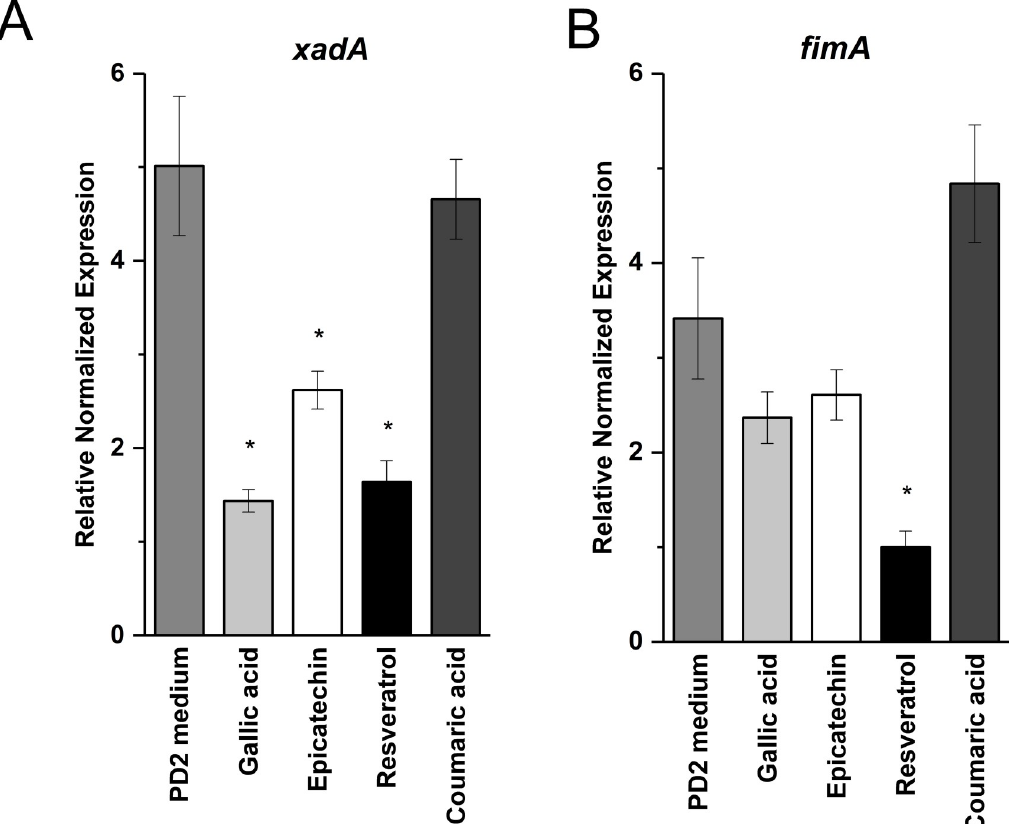
Fig 4. Reduced expression of adhesion-related genes in the presence of phenolic compounds. Expression of xadA (A) and fimA (B) in X . fastidiosa after 7 d of growth in the presence of gallic acid (1000 mg/ml), epicatechin (200 mg/ml), resveratrol (15 mg/ml), or coumaric acid (60 mg/ml). Data are expressed as means ± standard deviation of three independent experiments, each consisting of three biological replicates ( n = 9). Significant differences (p-value < 0.05) in gene expression, relative fold change, standard error, and confidence intervals were all calculated by the CFX Manager